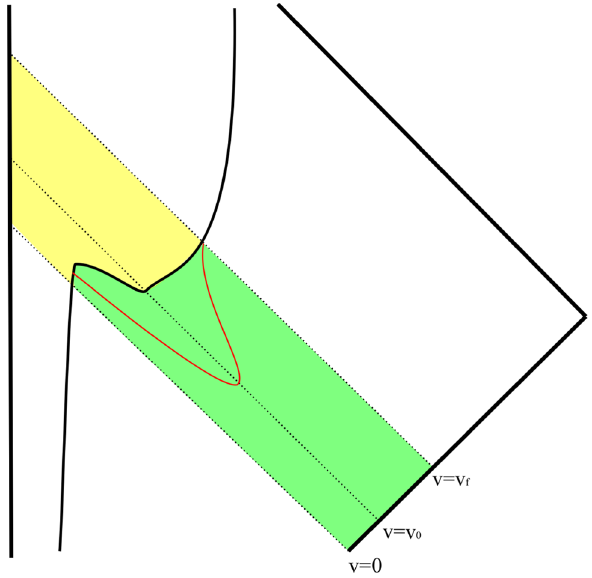
Fig. 5 The causal structure of the rapidly evaporating black hole